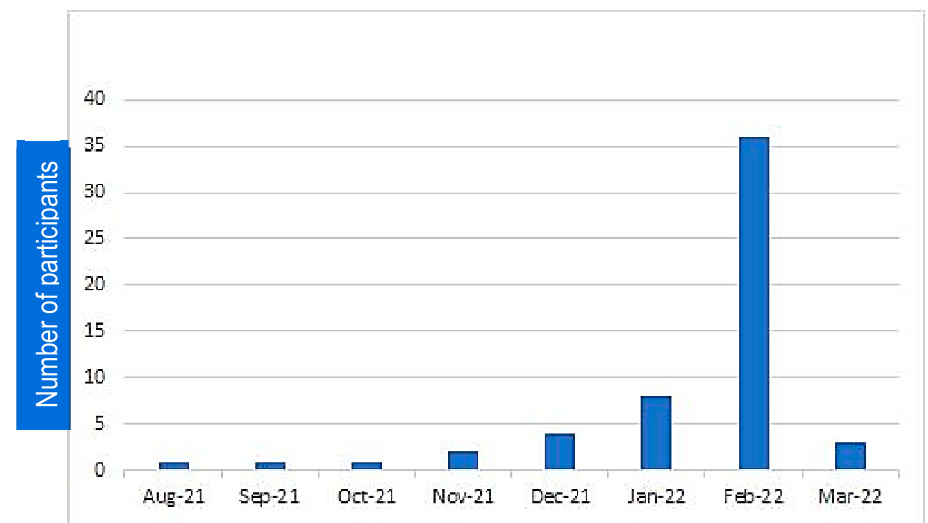
Figure 3. COVID-19 events within 5 months of the booster vaccination (n = 56). As seen in this figure,